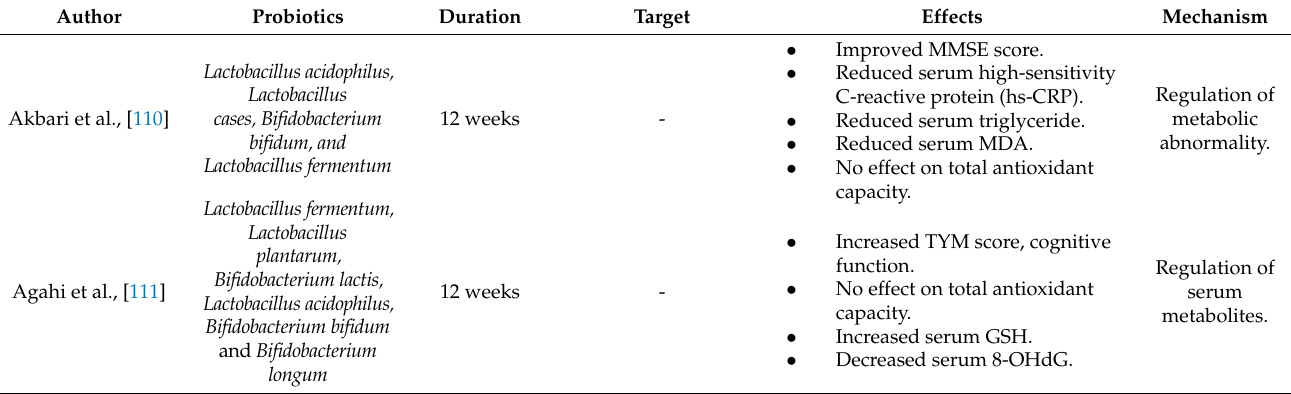
Table 2. Effects of probiotics in clinical